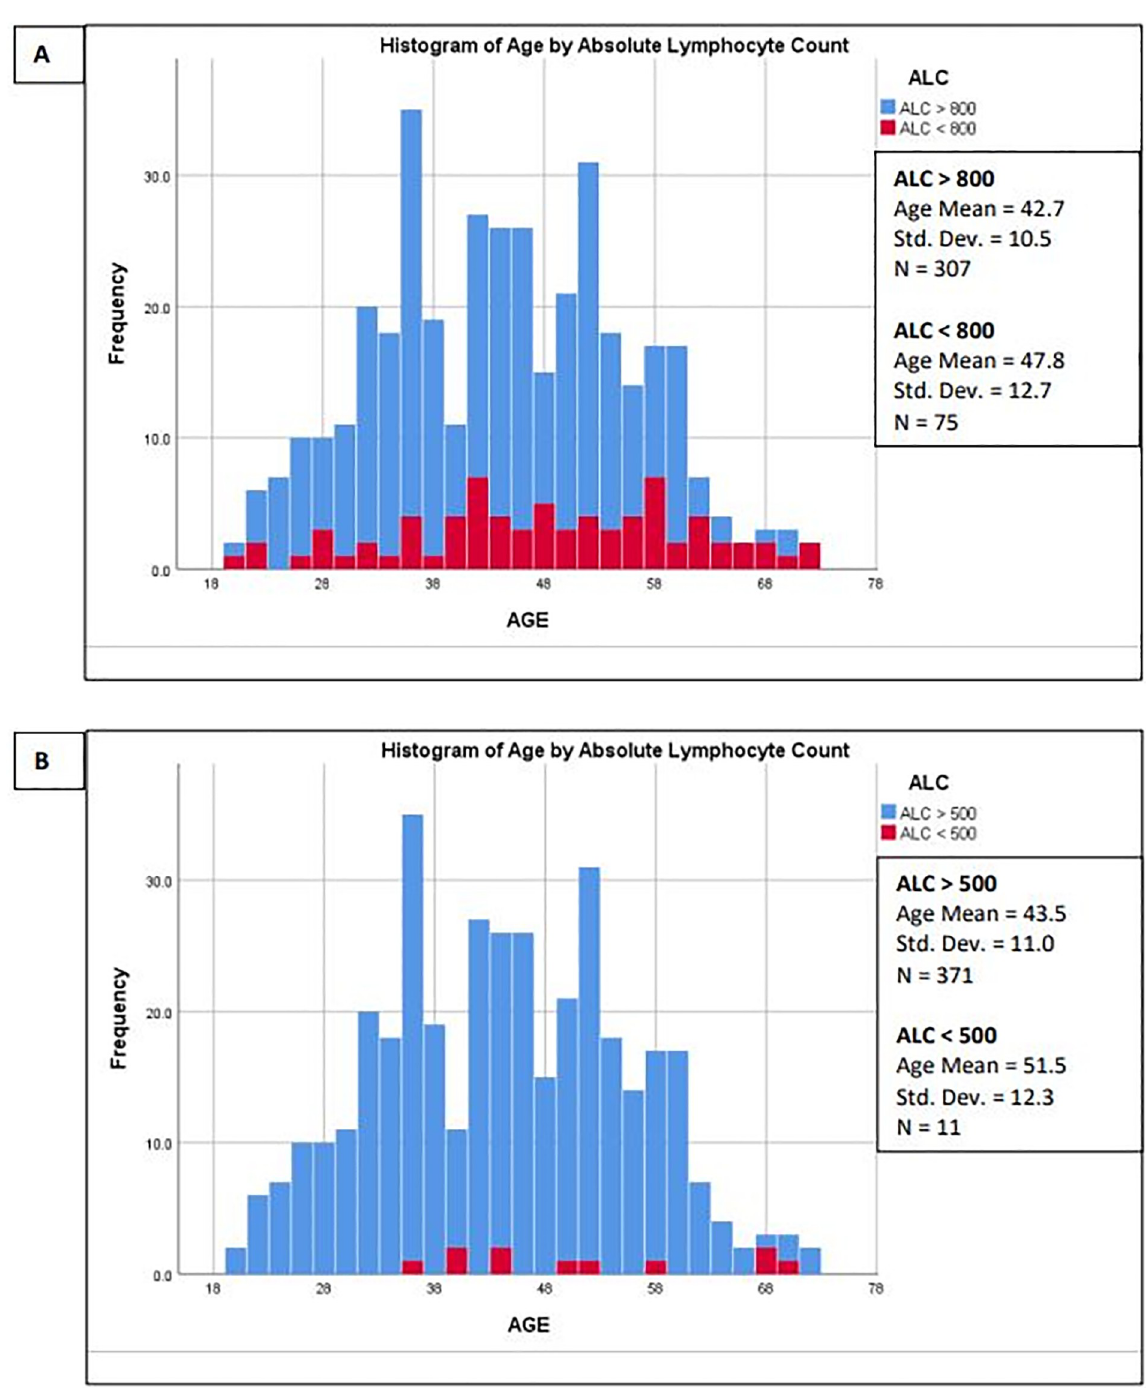
Fig 1. Increasing age is associated with lymphopenia in DMF-treated patients. Figures demonstrates age distribution for (A) absolute lymphocyte count (ALC) > 800. (B) absolute lymphocyte count (ALC) >